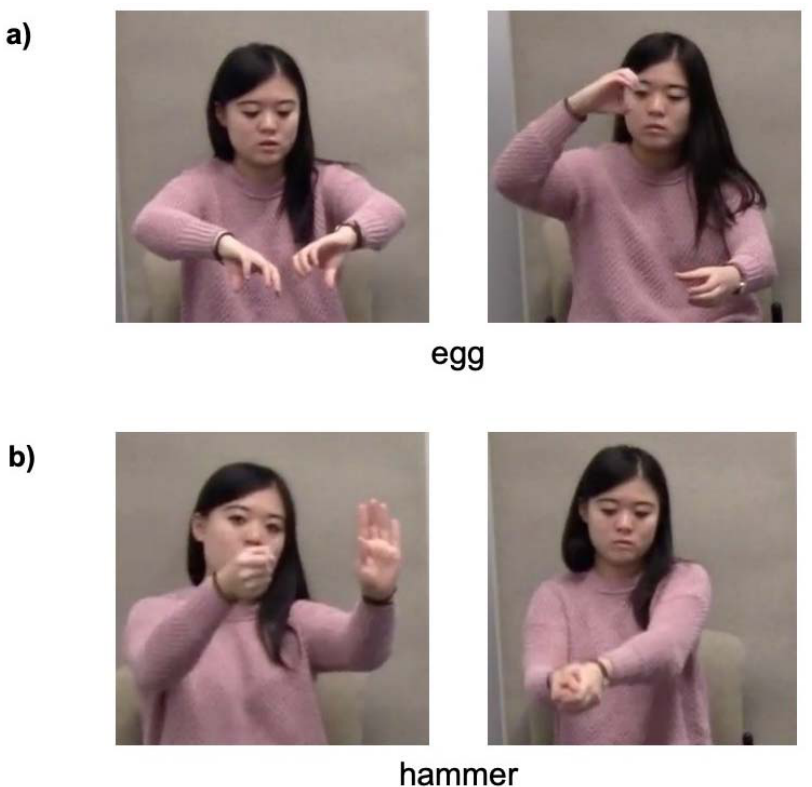
Figure 4. Example of gestures representing targets: ( a ), representing the target item egg where the two forms (left, right) have different underlying representations ( b ) representing the target item hammer, where the two forms (left, right) have the same underlying representations.